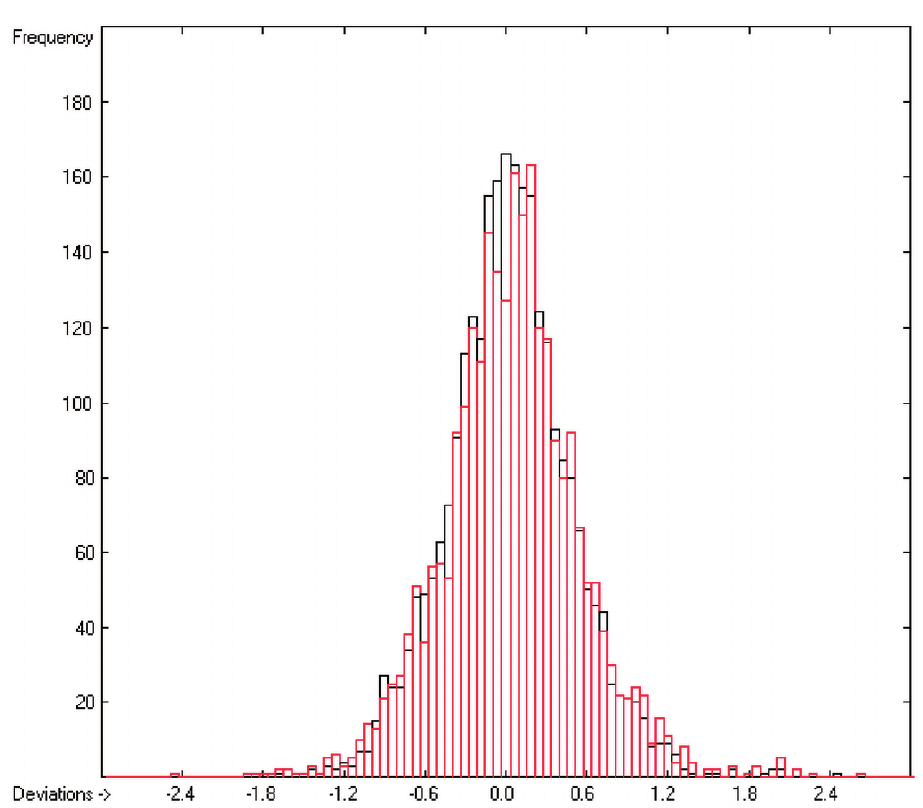
Figure 5. Correlation diagram of logP data (10-fold cross-validated: N = 2640, Q 2 = 0.9451, slope = 0.96).